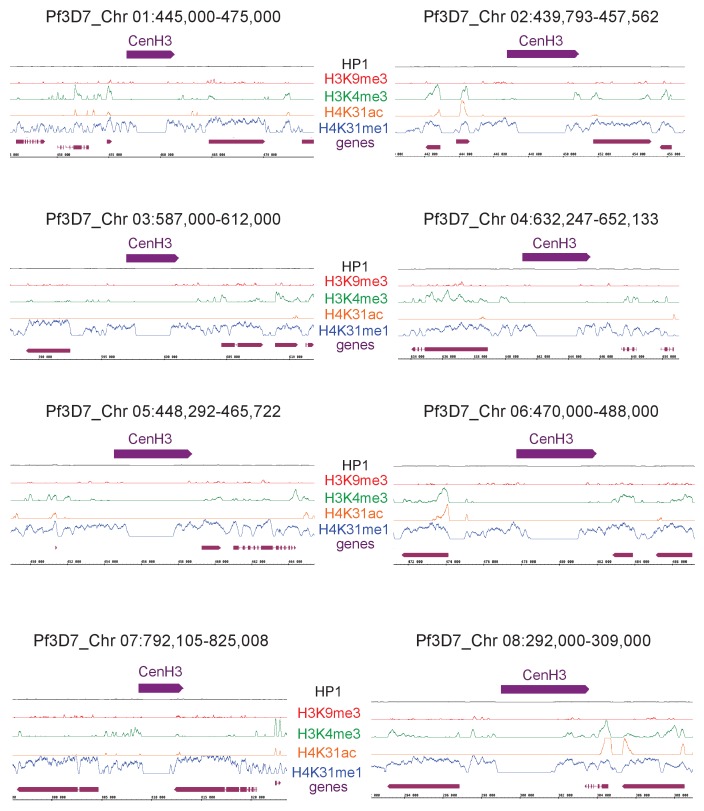
H4K31me1 marks pericentromeric chromatin in P. falciparum.Zoomed-in views of centromeric and peri-centromeric chromatin from P. falciparum chromosomes.